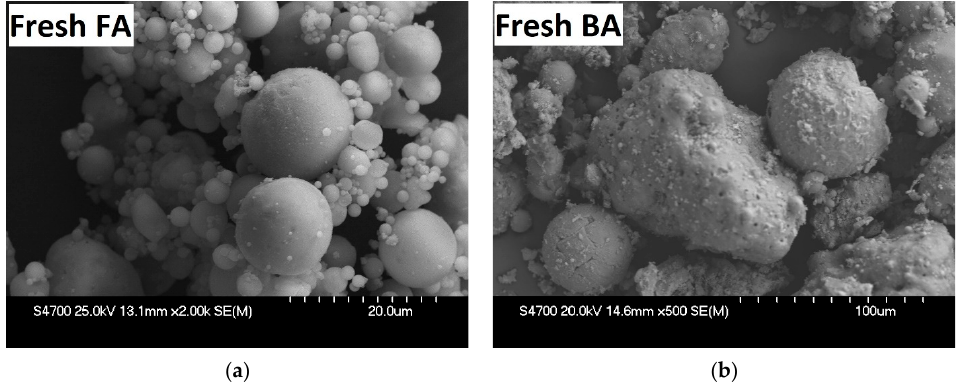
Figure 7. SEM Images of Fresh FA ( a ), magnified 2000× and Fresh BA ( b ), magnified 500×.